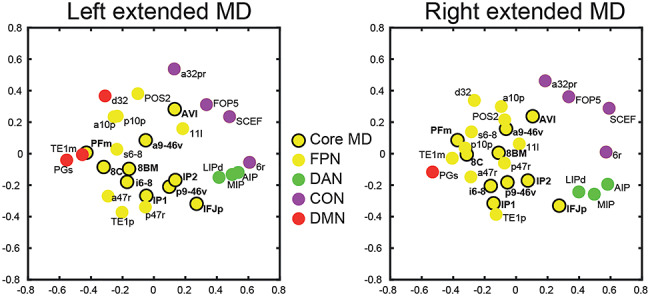
Multidimensional scaling plot of the connectivities between extended MD regions. Axis units are arbitrary. Data available at http://balsa.wustl.edu/jjL1x.